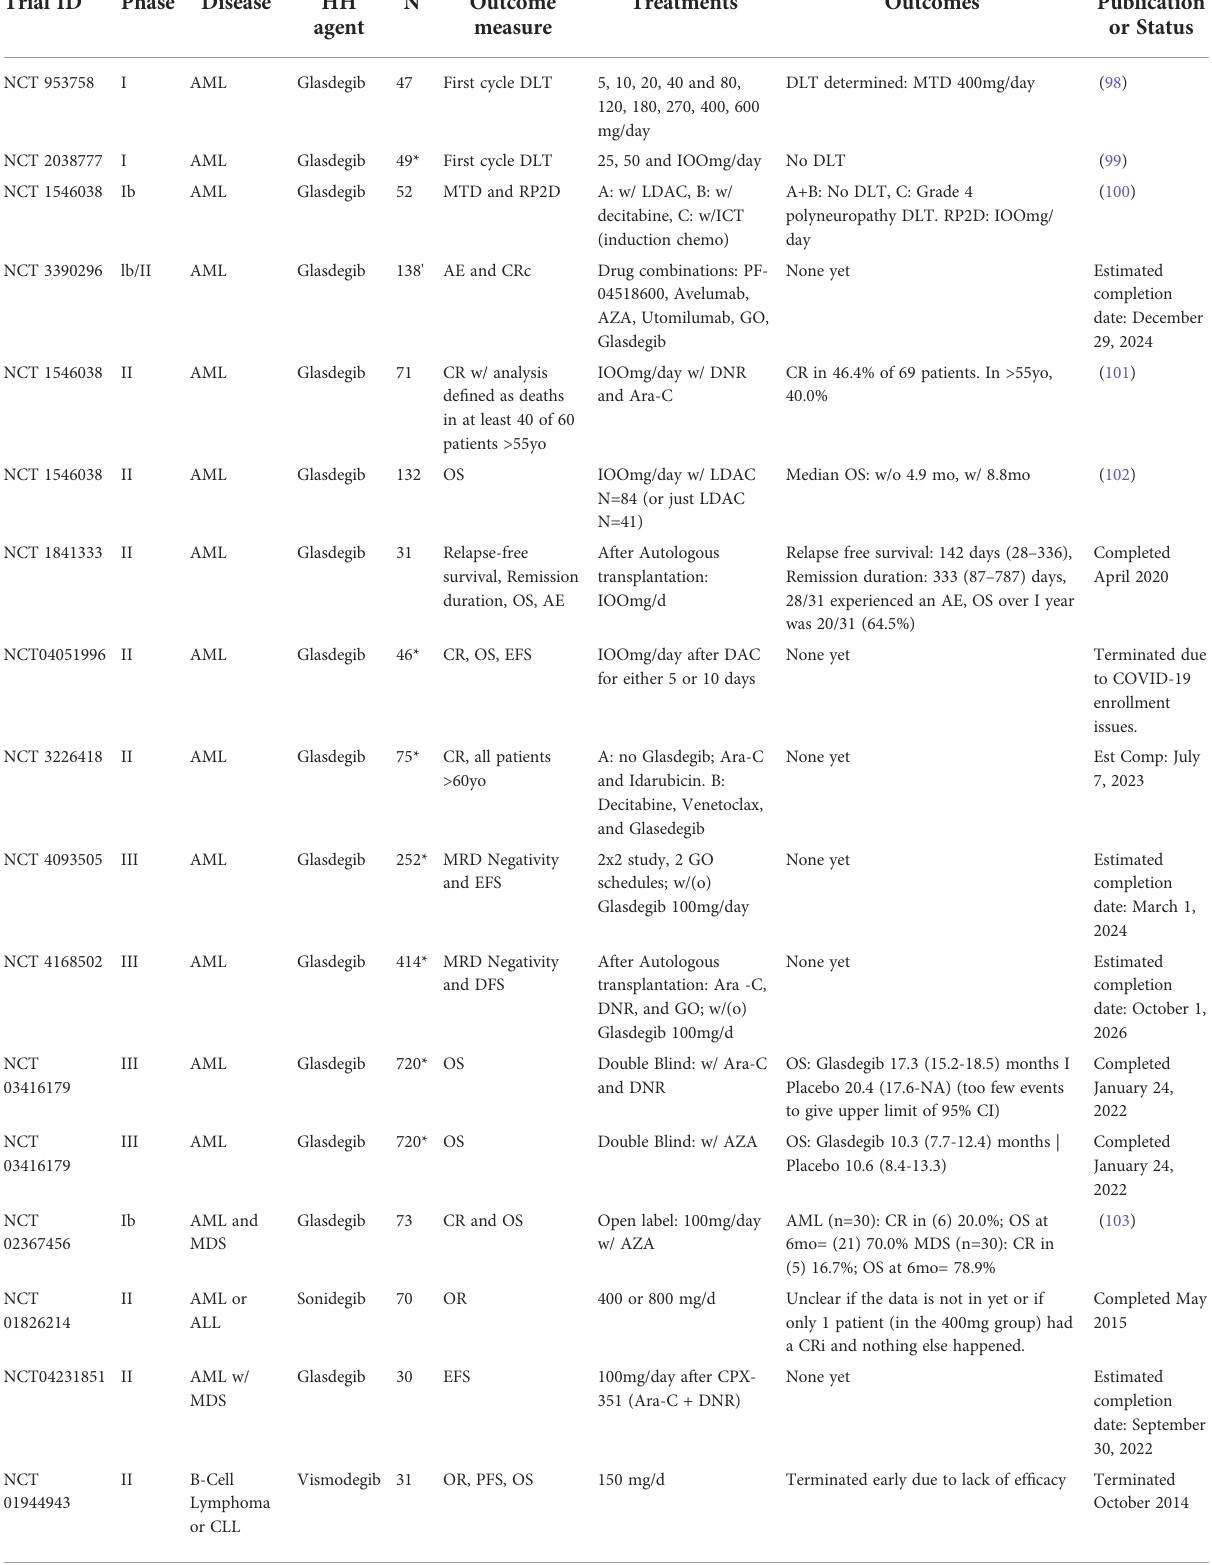
TABLE 1 List of clinical trials of SMO inhibitors in hematological malignancies (from clinical trials.gov). Trial